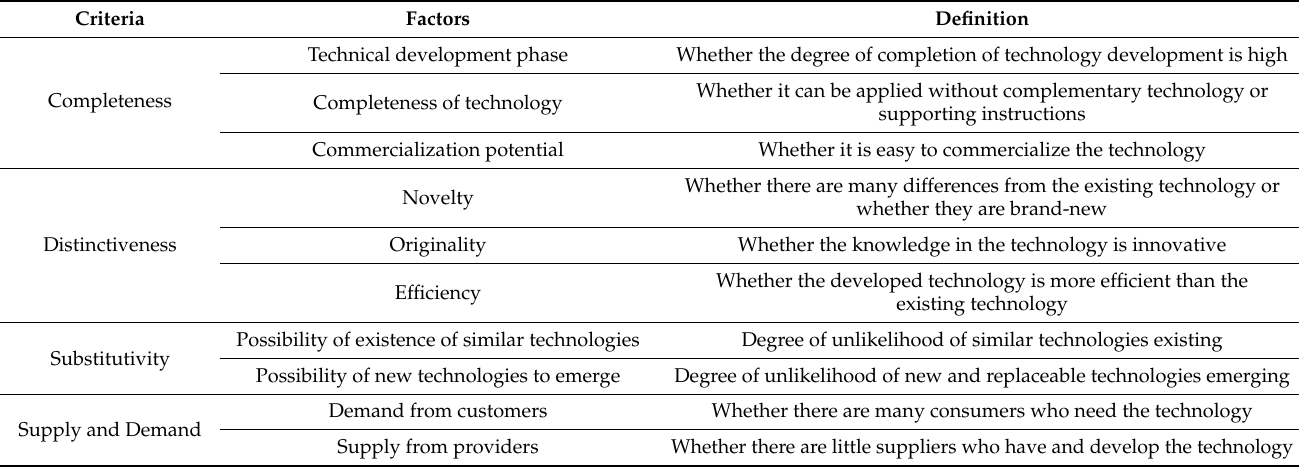
Table 3. Definition of criteria and factors of